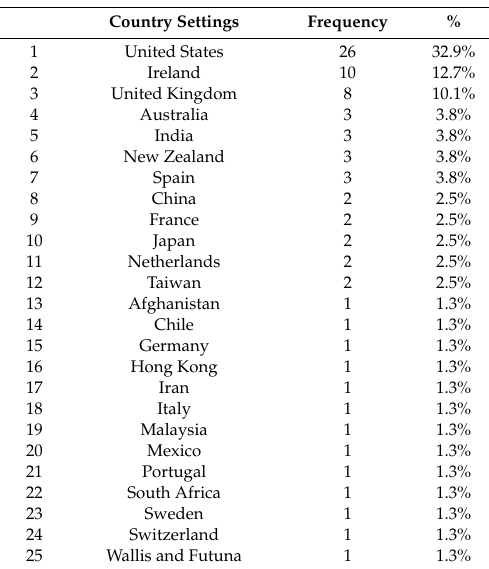
Table 3. Number of papers by countries as study